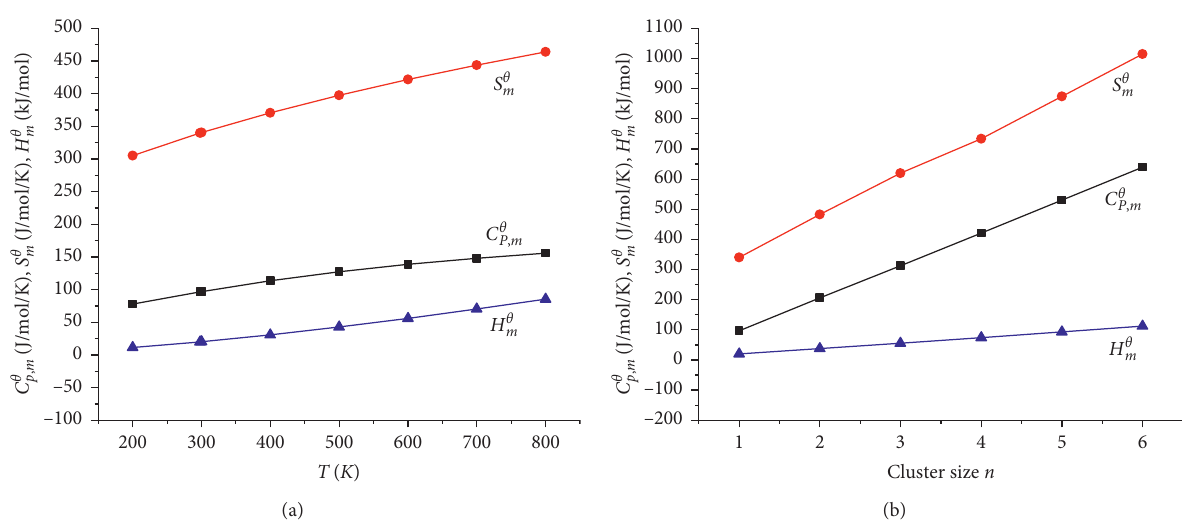
Figure 4: Variations of the thermodynamic functions ( C θ cluster size n (b) and for the asymmetric clusters (CH 3 FBN 3 ) n ( n �